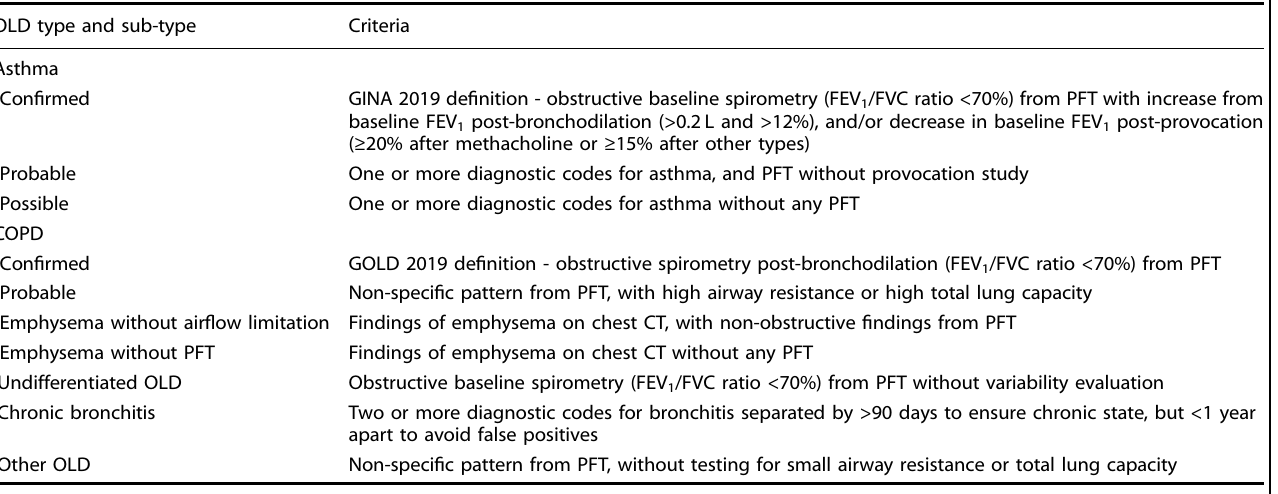
Table 1. Diagnostic criteria for speci fi c types of obstructive lung disease (OLD). OLD type and